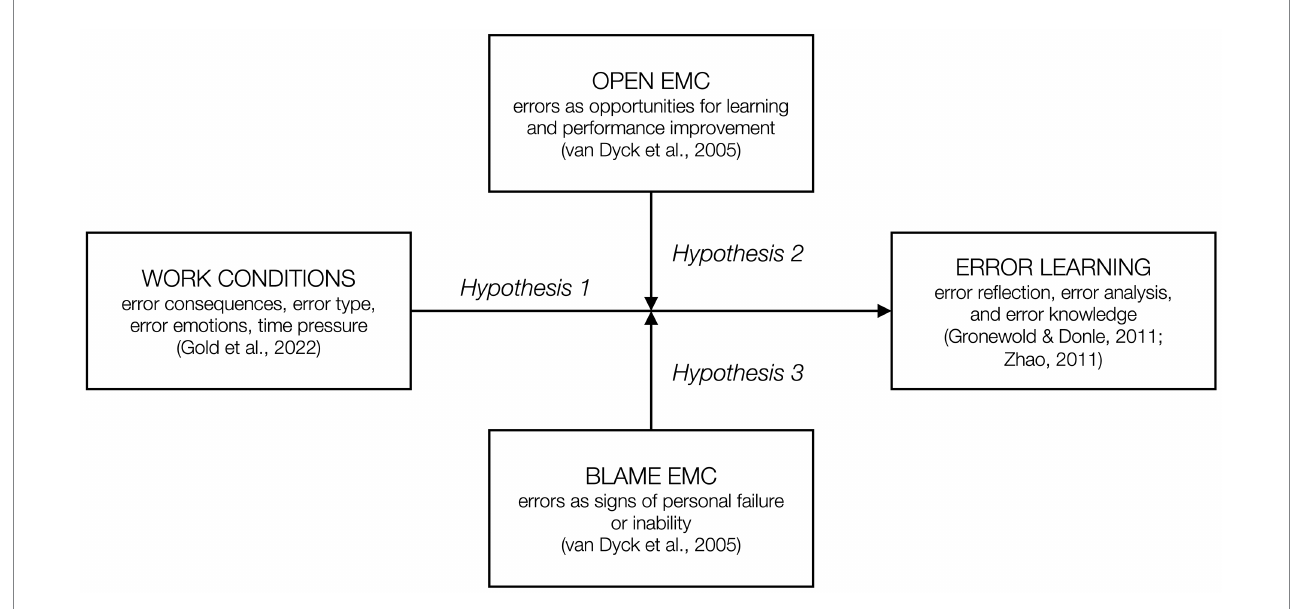
FIGURE 1 Conceptual